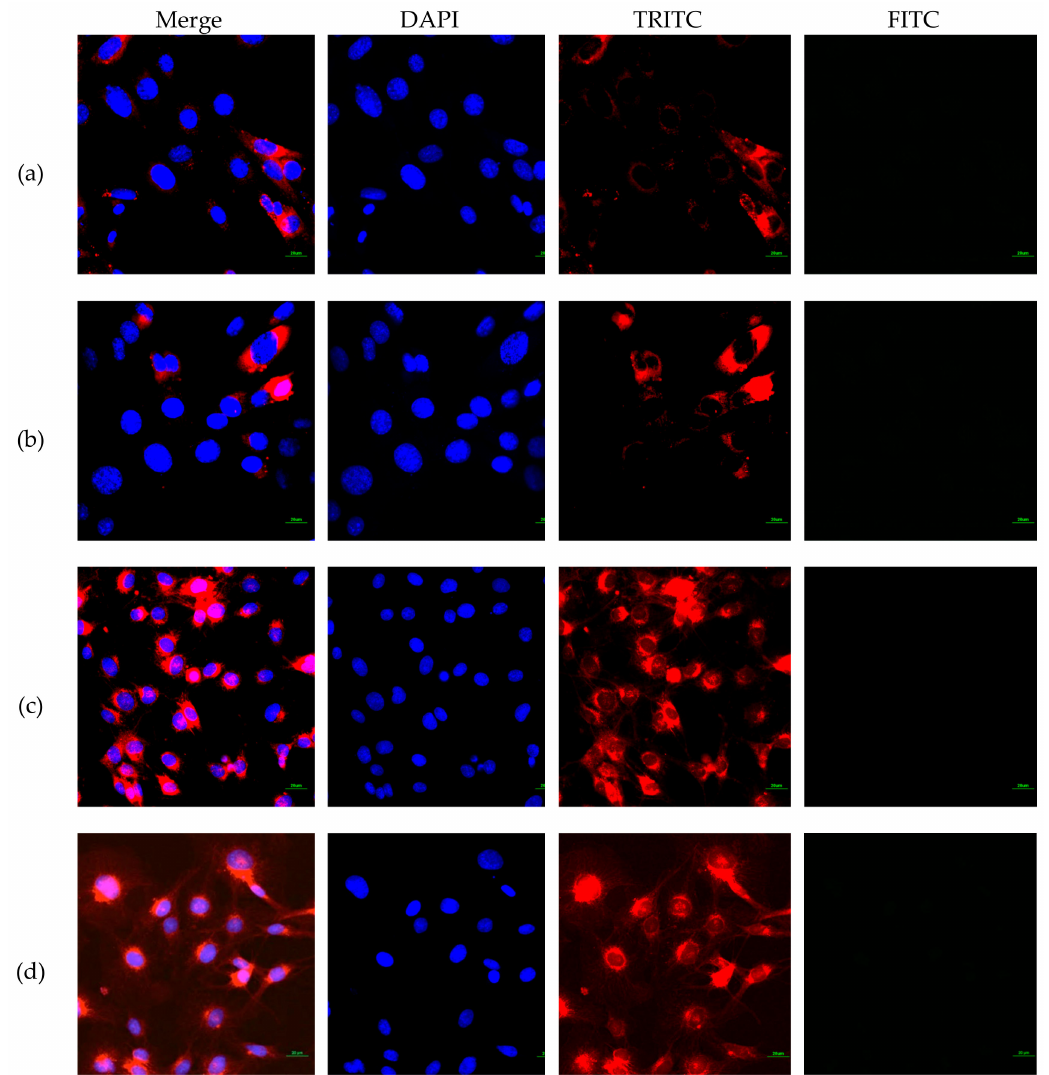
Figure 7. Confocal images of ( a ) FITC-treated NIH3T3, ( b ) FITC-CNC-treated NIH3T3, ( c ) FITC-treated C6, and ( d ) FITC-CNC-treated C6 cells viewed under 4 (cid:48) ,6-diamino-2-phenylindole (DAPI), tetramethylrhodamine isothiocyanate (TRITC), and FITC filters. Scale bar = 20 µ